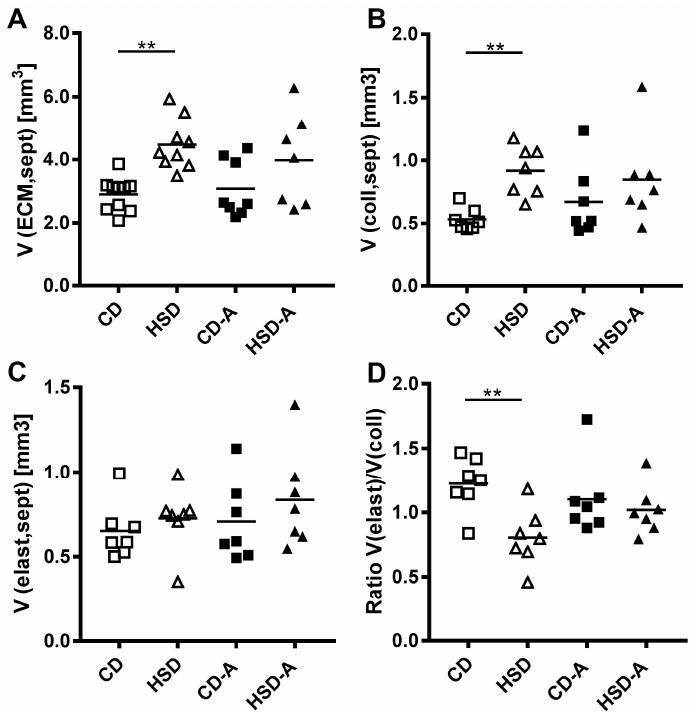
Figure 5. Effects of high sucrose intake and voluntary activity on extracellular matrix composition. Mice were fed a control diet (CD) or a high sucrose diet (HSD) and were left untreated or had access to running wheels (CD-A, HSD-A) for 30 weeks. ( A ) Volume of septal extracellular matrix; ( B ) Volume of septal collagen fibers; ( C ) Volume of septal elastic fibers; ( D ) Ratio of the elastic fiber volume to the collagen fiber volume. Values are individual data points, with means indicated by horizontal lines. Data were compared by 2-Way ANOVA followed by Tukey test; p -values < 0.05 are indicated: ** p < 0.01.